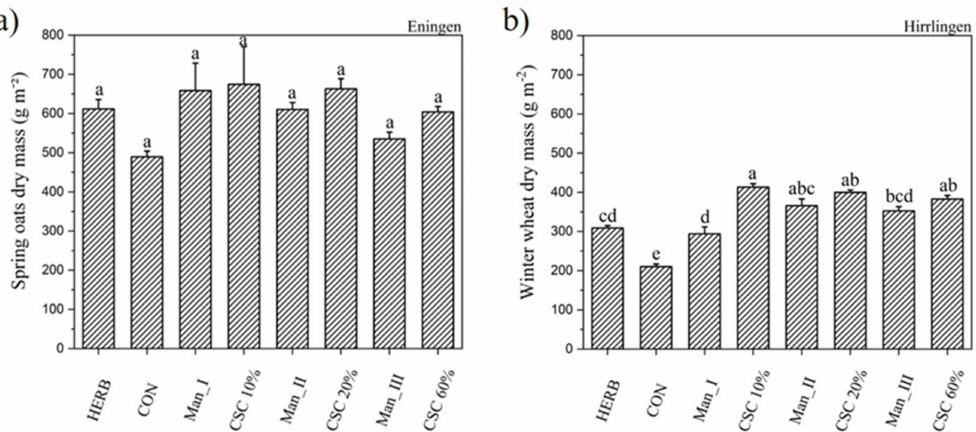
Figure 4. Dry biomass (g m − 2 ) of spring oats in Eningen, p = 0.1445 ( a ) and winter wheat in Hirrlingen, p = 1.458 × 10 − 7 ( b ) in 2020. Biomass was measured at BBCH 49 in Eningen and BBCH 59 in Hirrlingen. Means with the same letter were not significantly different according to the HSD-test at α ≤ 0.05. HERB = herbicide application, CON = untreated control, conventional intensity (Man_) I, II, and III = tine angle 10 ◦ , 40 ◦ and 70 ◦ ; Crop soil cover (CSC) 10, 20, and 60% = plant burial by 10, 20, and 70% soil. The error bars show the standard